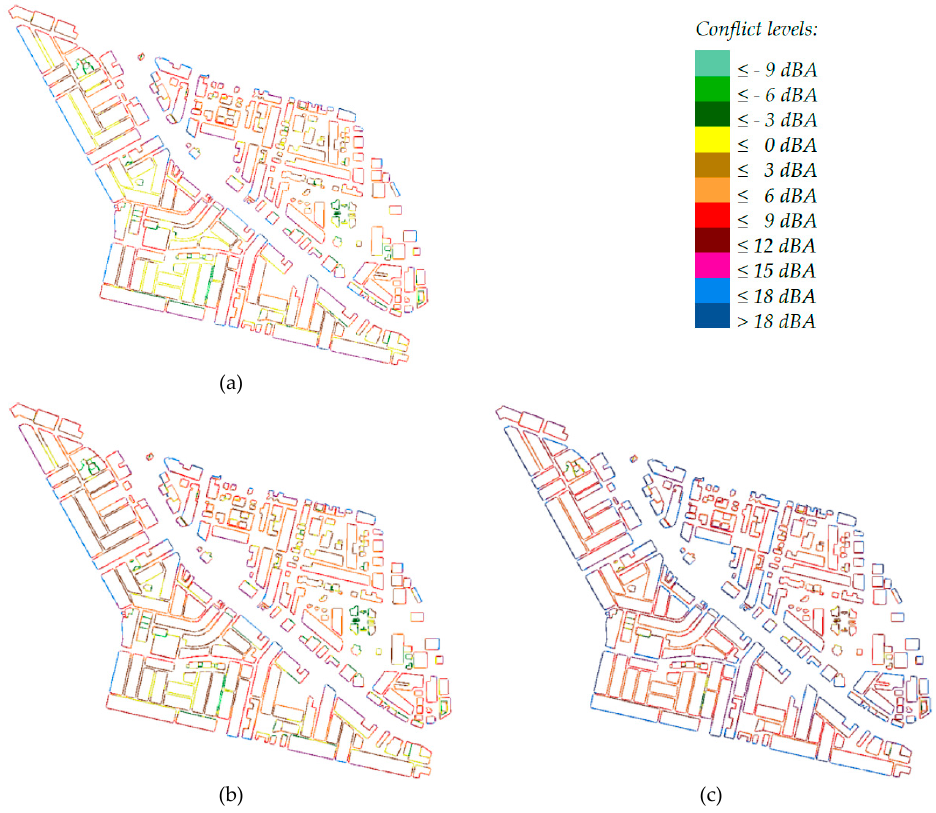
Figure 6. Average Facade noise conflict levels according to Saudi regulation: ( a ) Daytime conflict levels; ( b ) Evening time conflict levels; ( c ) Nighttime conflict